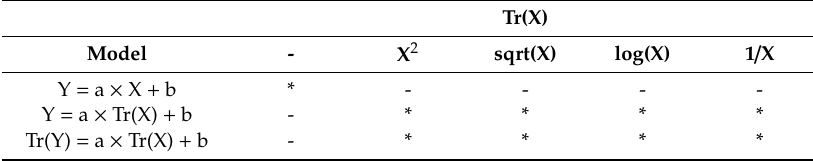
Table 3. Regression models and transformation of variables applied. The symbol * represents the tested combinations of models and transformation of